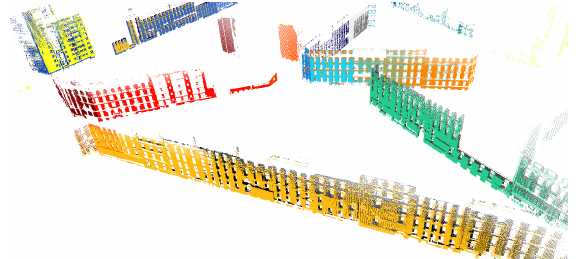
Figure 16: Point cloud data without outliers. Inlier points of a detected rectangle have the same color. It happens one facade to be swept several times. Then, a shift due to georeferencing problems may appear between detected rectangles, as the yellow and the dark ones at the